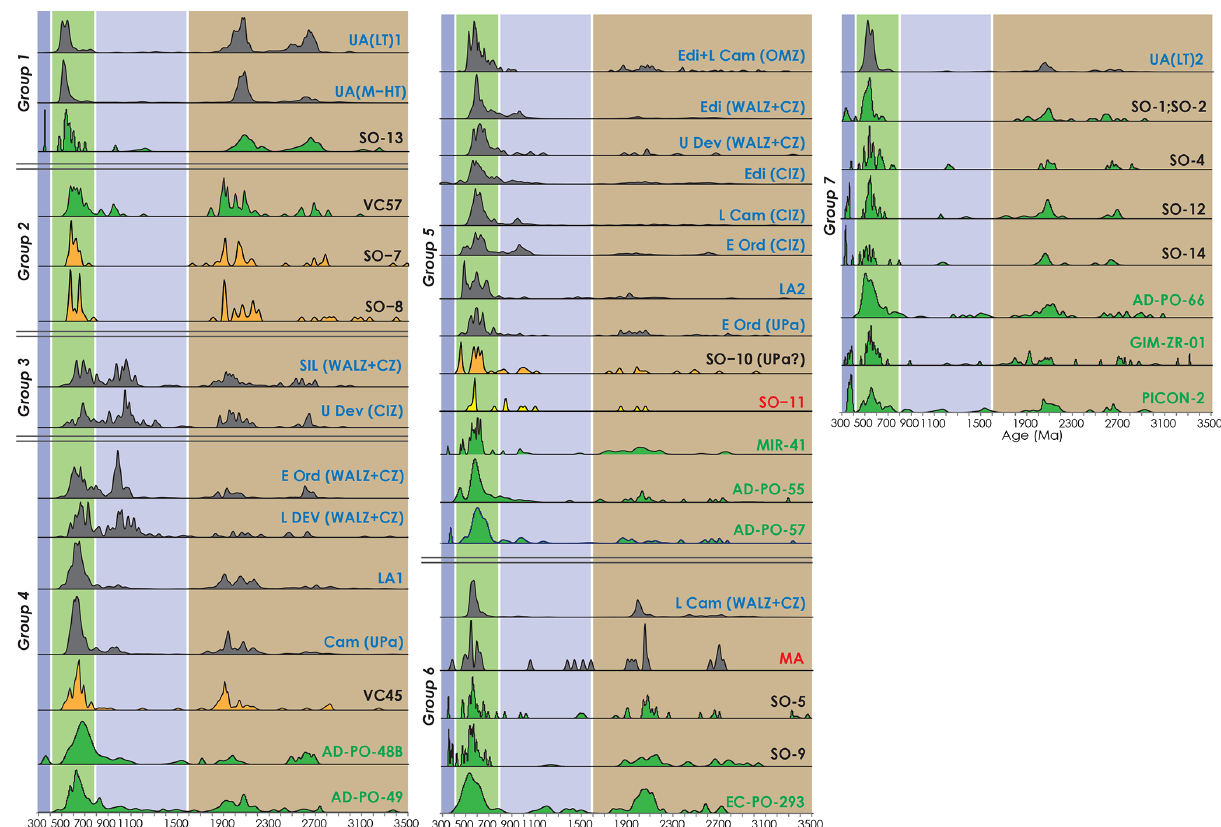
Figure 13. Age distribution plots of all groups belonging to the Cluster 2 populations: “multiple Gondwana-derived sources”. Legend is in Fig. 12. See text and the Supplement for a detailed